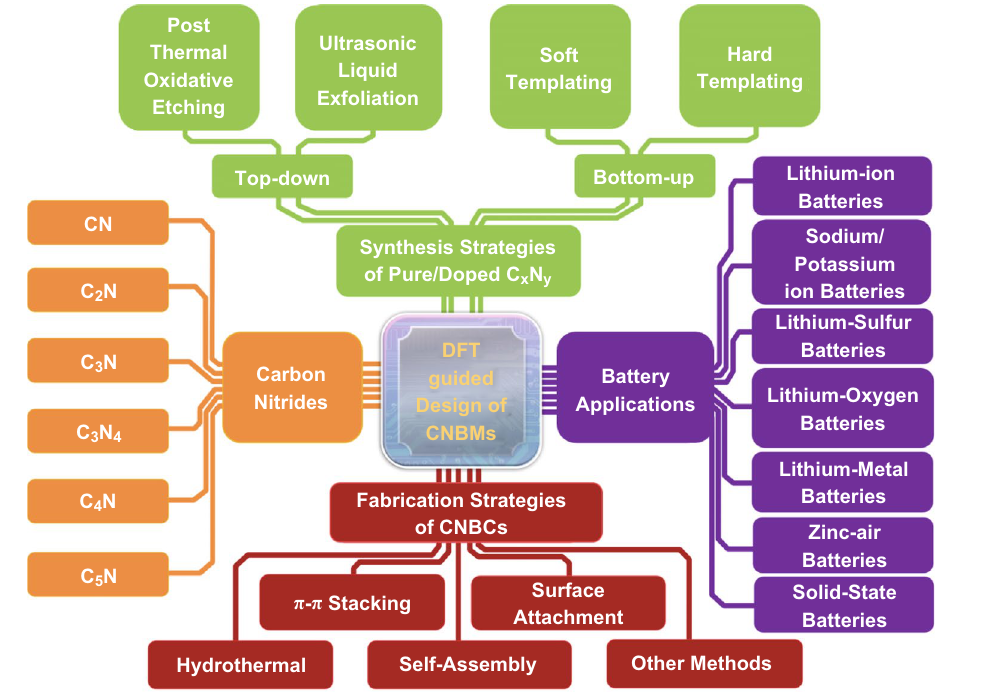
Fig. 1 Overview of the main topics of this work, including DFT-guided design (symbolized by the “CPU” at the center), the molecular configu- ration of carbon nitrides (yellow block), the synthesis strategies of pure/doped carbon nitrides (green block), the fabrication strategies of CNBCs (red block) and the battery applications of CNBMs (purple block). (Color figure online)